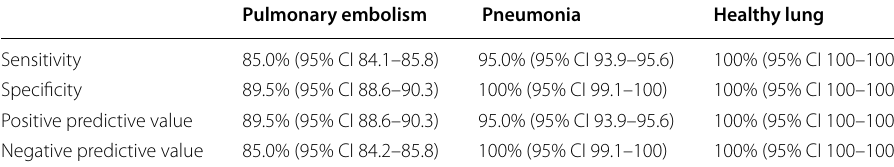
Table 7 Sensitivity, specificity, PPV and NPV statistics for diagnosis at lesion level